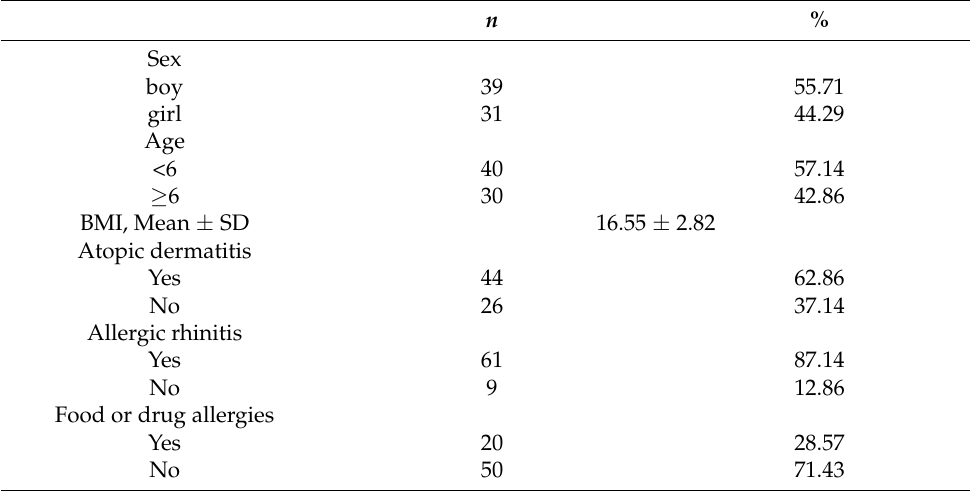
Table 1. Description of basic demographic information ( n =